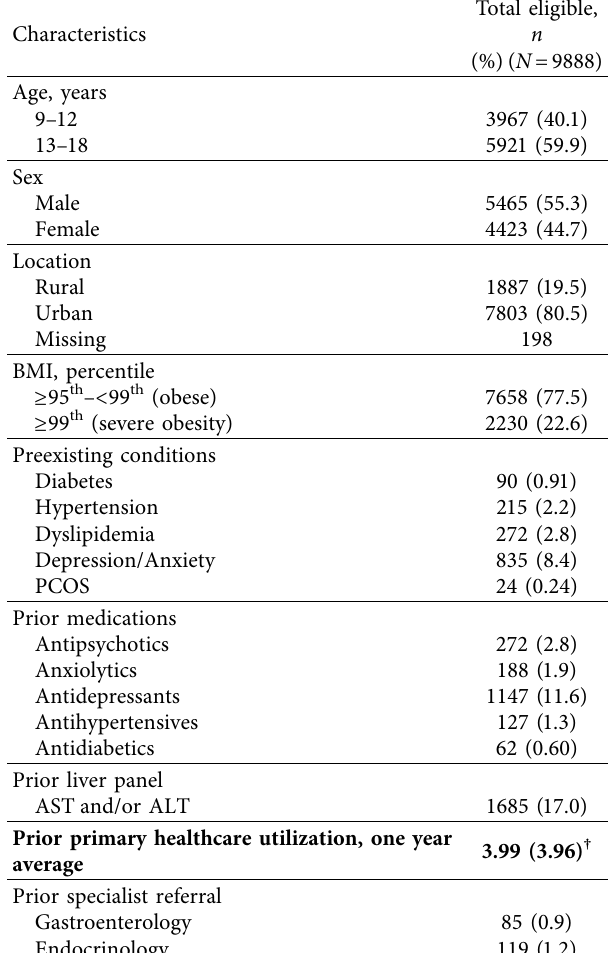
Table 1: Eligible NAFLD screening population.